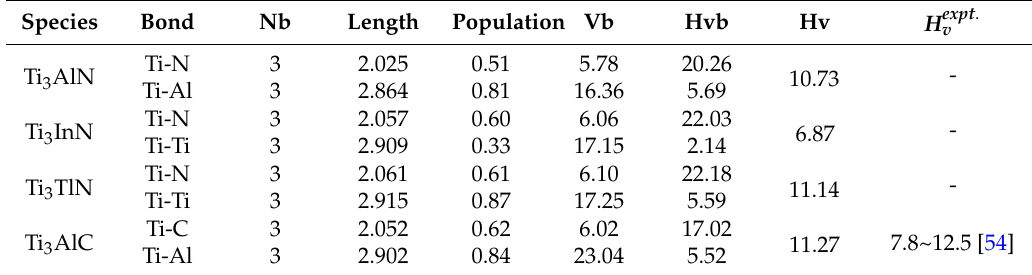
Table 3. Bond types, number of bonds in unit crystal, bond length, population, bond volume (Å 3 ), bond hardness and hardness